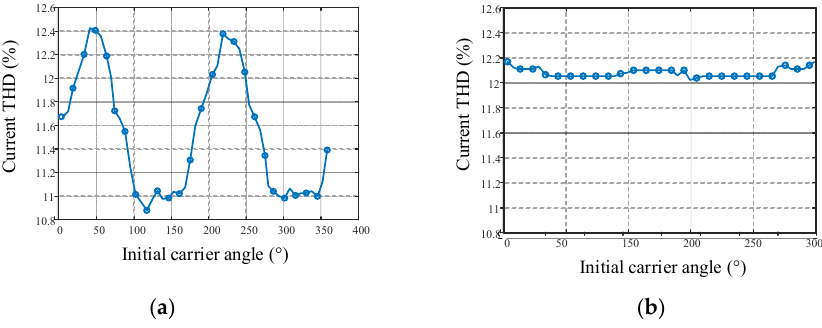
Figure 5. Output current THD with changing initial carrier angels. ( a ) C r = 7 ( b ) C r = 7.3.